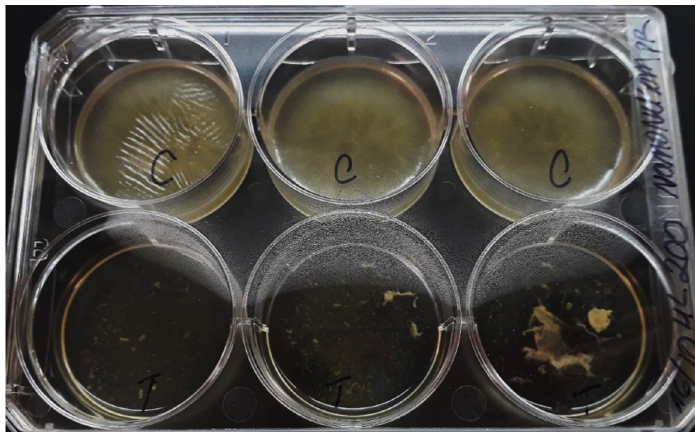
Figure 5. Biofilm eradication capacity and phenotype recovery of MIC NQo on Pseudomonas sp. at room temperature (25 °C).